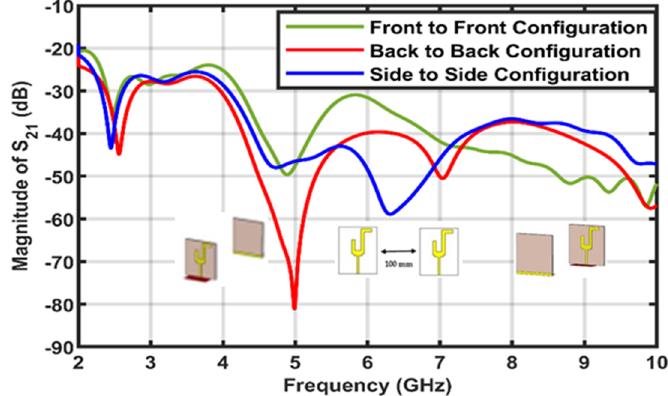
Figure 24. S 21 analysis of the antenna for various configurations in free space.